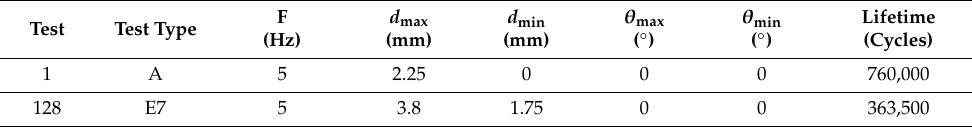
Table 2. Information of the Ayoub battery tests. Initial test data adapted from [46].